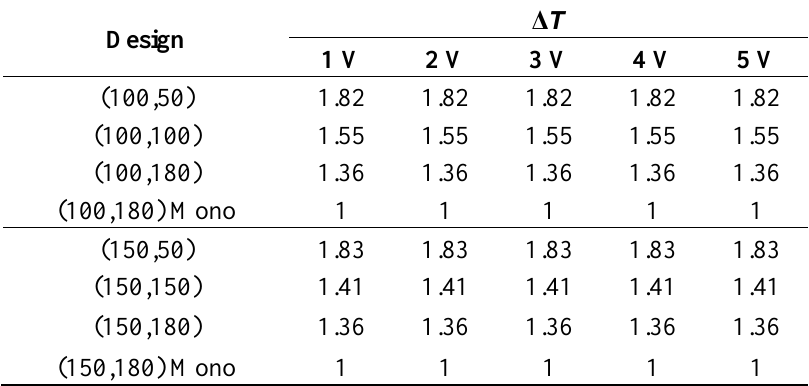
Table 3. Normalised average temperature increase in the piezoresistor of different ( l , l microcantilever designs due to